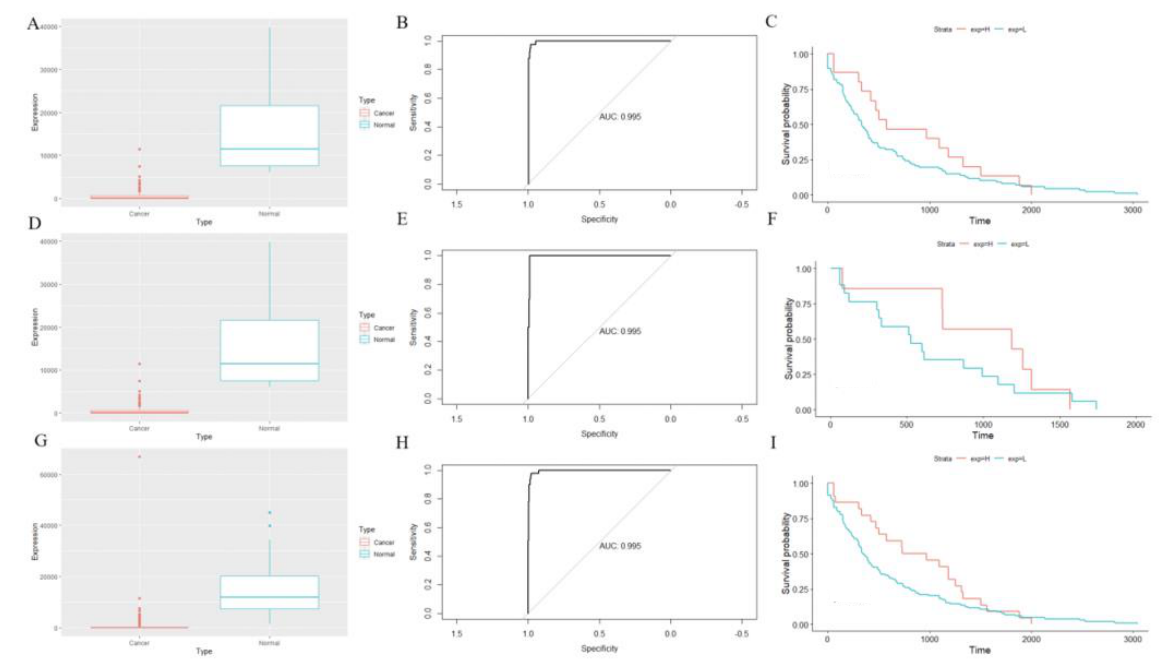
Figure 6. CHGA expression distribution of colon cancer ( A ), rectal cancer ( D ) and CRC ( G ) compared with normal controls. CHGA had a significant difference in cancers with normal controls. Diagnostic ROC test for CHGA in colon cancer ( B ), rectal cancer ( E ), and CRC ( H ). With AUCs of 0.995, GHGA showed a high potential of being a good diagnostic biomarker in CRC. Survival curves of CHGA in colon cancer patients ( C ), rectal cancer patients ( F ), and CRC patients ( I ). CHGA performed poorly in the prognosis of CRC ( p value = 0.24, 0.38, and 0.13, respectively).